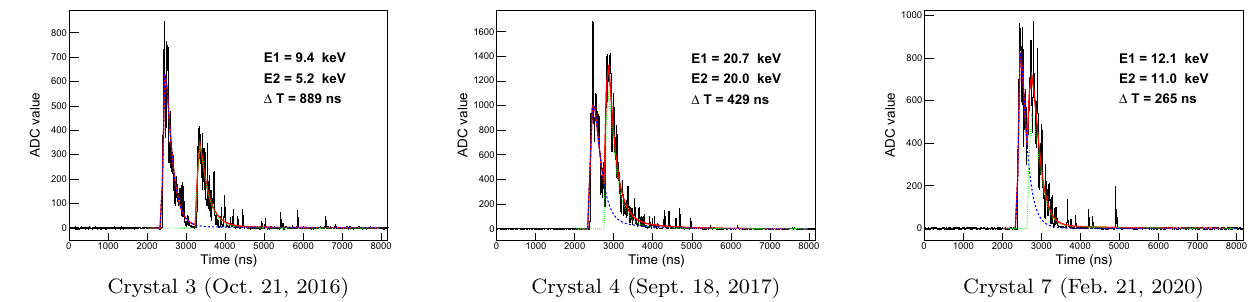
Fig. 3 The results of fits to the two pulses (lines) for the events in Fig. 2. The energies of each pulse (E1 and E2) and the time difference ( (cid:6) T) are listed.